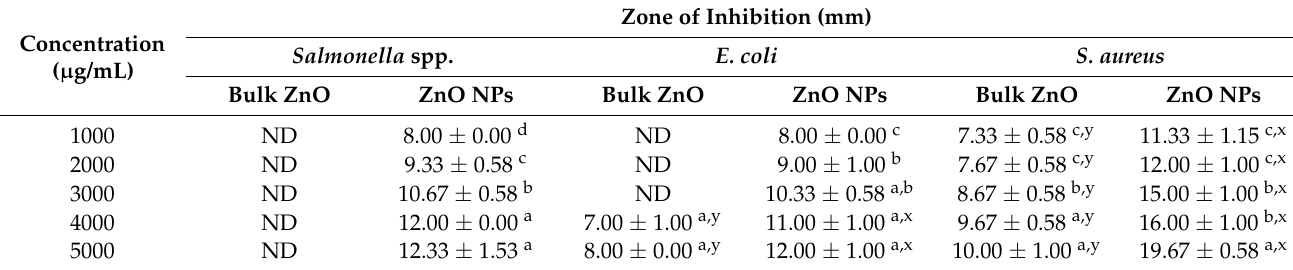
Table 1. Antibacterial activity of bulk ZnO and zinc oxide nanoparticles (ZnO NPs) against Salmonella spp., E. coli , and S. aureus at various concentrations. The antibacterial activity was measured by the inhibition zone in millimeters (mm). Zone of Inhibition (mm) Concentration Salmonella spp. E. coli S. aureus ( µ g/mL)